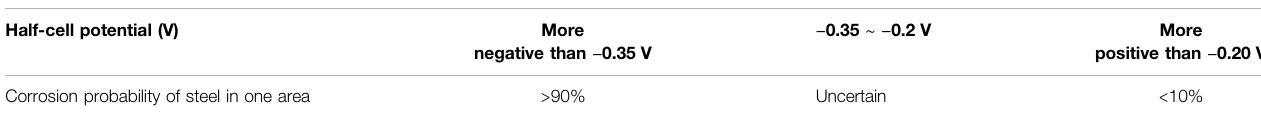
TABLE 4 | Corrosion probability of reinforcing